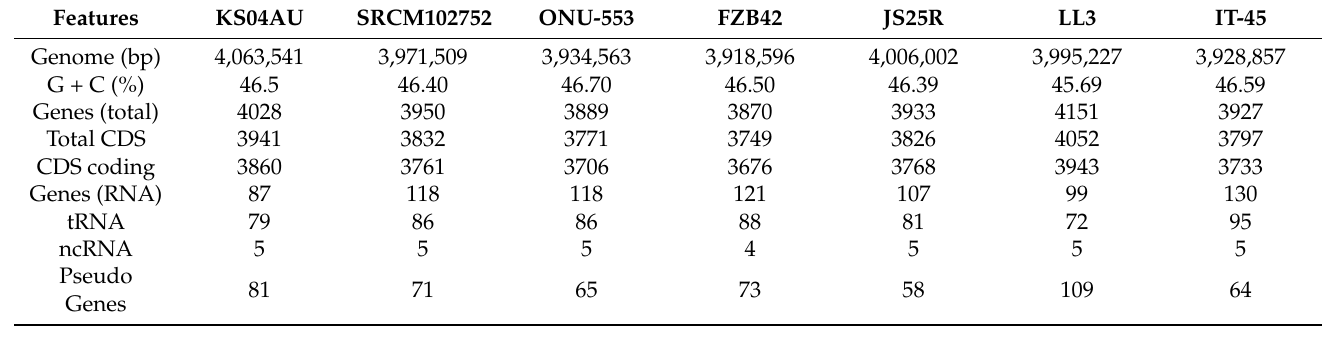
Table 2. Comparative genomic features of B. velezensis KS04AU with closest-related strain.